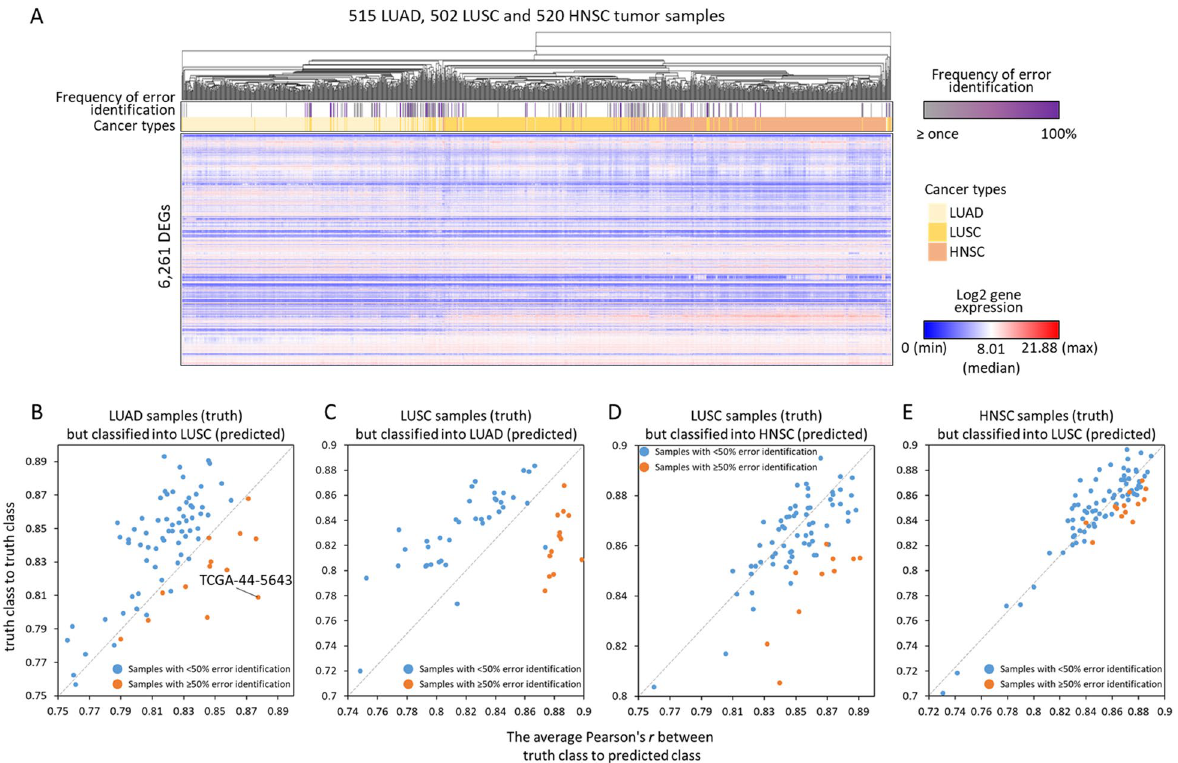
Figure 5. The correlation analysis of gene expression profiles between misjudged tumors and tumors in truth and predicted classes. ( A ) The heat map showed the unsupervised clustering analysis of gene expression in LUAD, LUSC and HNSC tumor samples. The intensity of gene expression for 6261 DEGs are presented in red color and blue color. To the top panels, three colors indicate LUAD (light yellow), LUSC (gold color) and HNSC (peach color) respectively. And the frequency of error identification is presented in grey (≥ 1 misjudgment) and purple color. In the four scatter plots ( B – E ), each dot represents the each misjudged tumor sample, and the orange dots means their frequencies of error identification ≥ 50% among the number of total prediction times, otherwise the ones were presented with blue dots. The plots illustrated the averaged gene expression correlation (i.e., Pearson’s r ) between the each misjudged tumor of ( B ) LUAD, ( C , D ) LUSC and ( E ) HNSC to every tumor in truth class cancers and in predicted class cancers. If the dots are below the diagonal that indicate the gene expression profiles of misjudged tumors are more similar to tumors in predicted classes than in truth